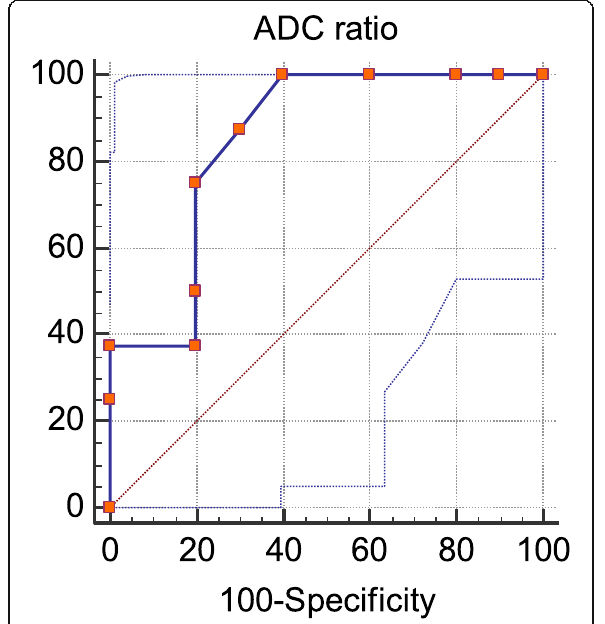
Fig. 9 ROC curve illustrates AUC, sensitivity, and specificity of ADC ratio in diagnosis of astrocytoma